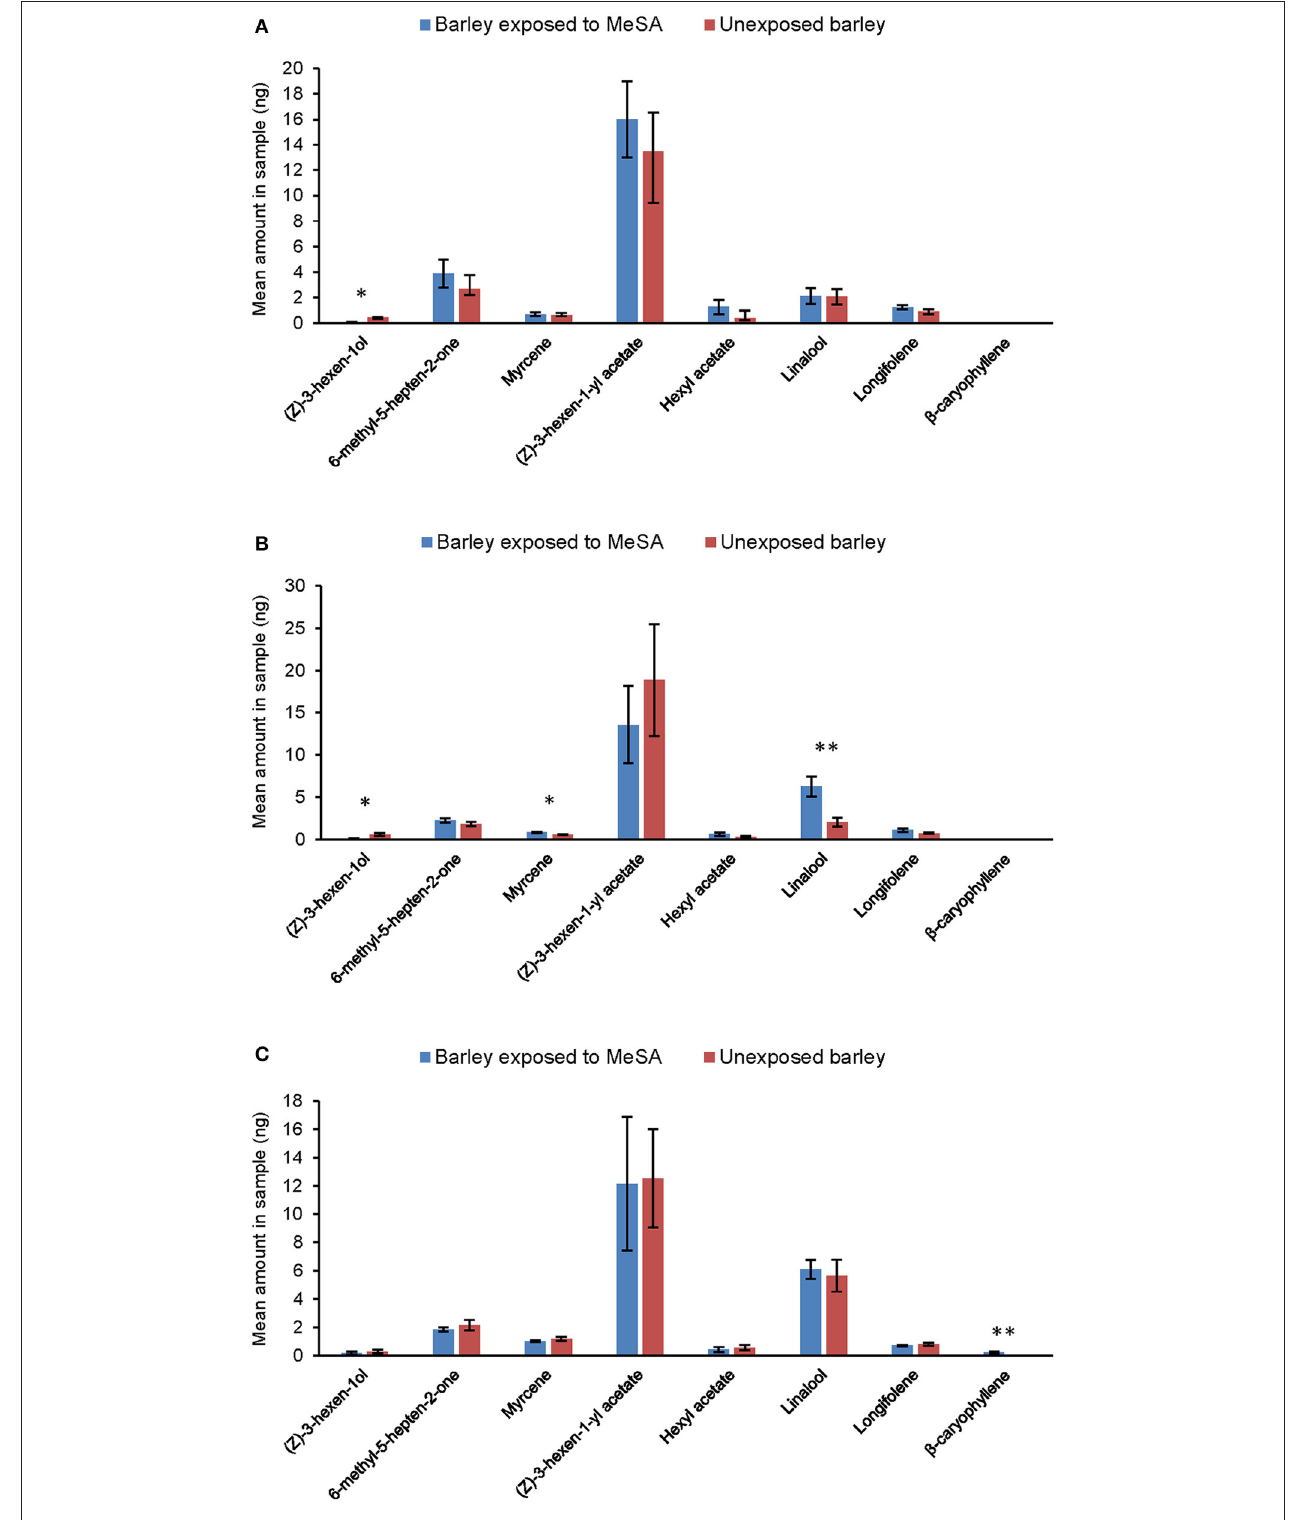
FIGURE 4 | Amounts of volatile compounds (mean ng ± SE) quantified in the headspace of unexposed barley plants and plants exposed to MeSA [directly after removal of MeSA exposure (Day 0) (A) and at time points 1 (B) and 3 days (C) after removal]. * p ≤ 0.05; ** p ≤ 0.01, after ANOVA. MeSA was analyzed in the headspace but, due to large differences in amounts, it is shown in a separate figure ( Figure 3 ).